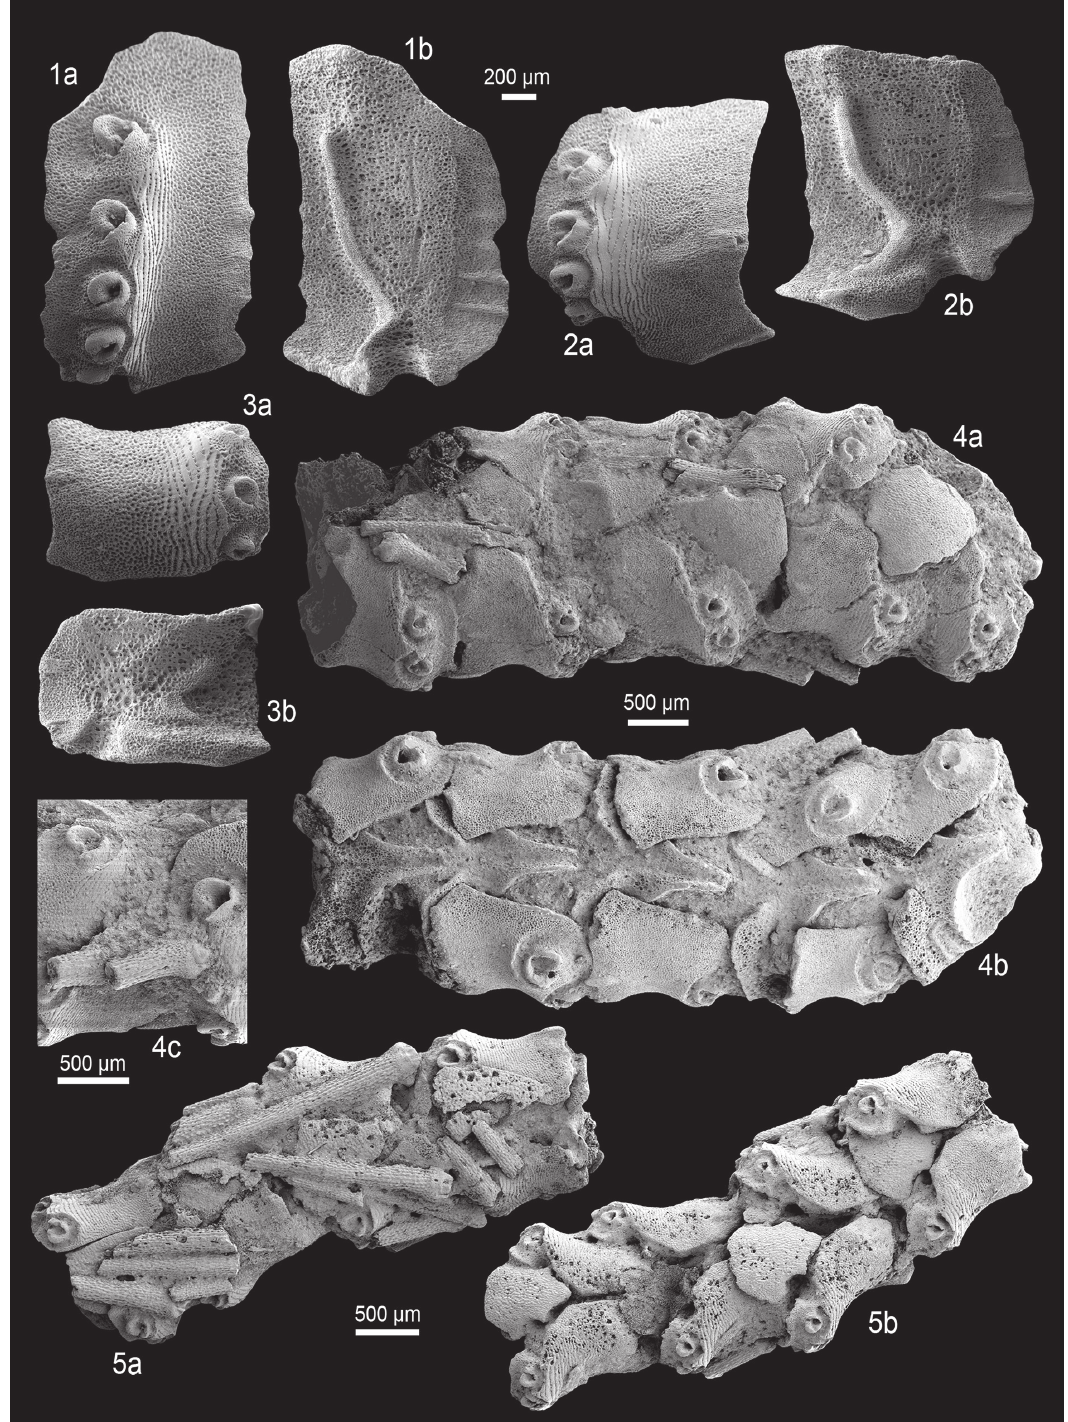
Fig. 23. Fossil lateral arm plates in external (a) and internal (b) views and articulated arm fragments of Alternacantha schwermannorum sp. nov. from the late Oxfordian (Late Jurassic) of Savigna, France. 1. GZG.INV.78654 (holotype), proximal LAP. 2. GZG.INV.78655 (paratype), median LAP. 3. GZG. INV.78656 (paratype), distal LAP. 4. GZG.INV.78657 (paratype), proximal arm fragment in ventral (a) and dorsal (b) views and with detail in dorso-lateral (c) view. 5. GZG.INV.78658 (paratype), distal arm fragment in dorsal (a) and ventral (b) view. One common scale bar for